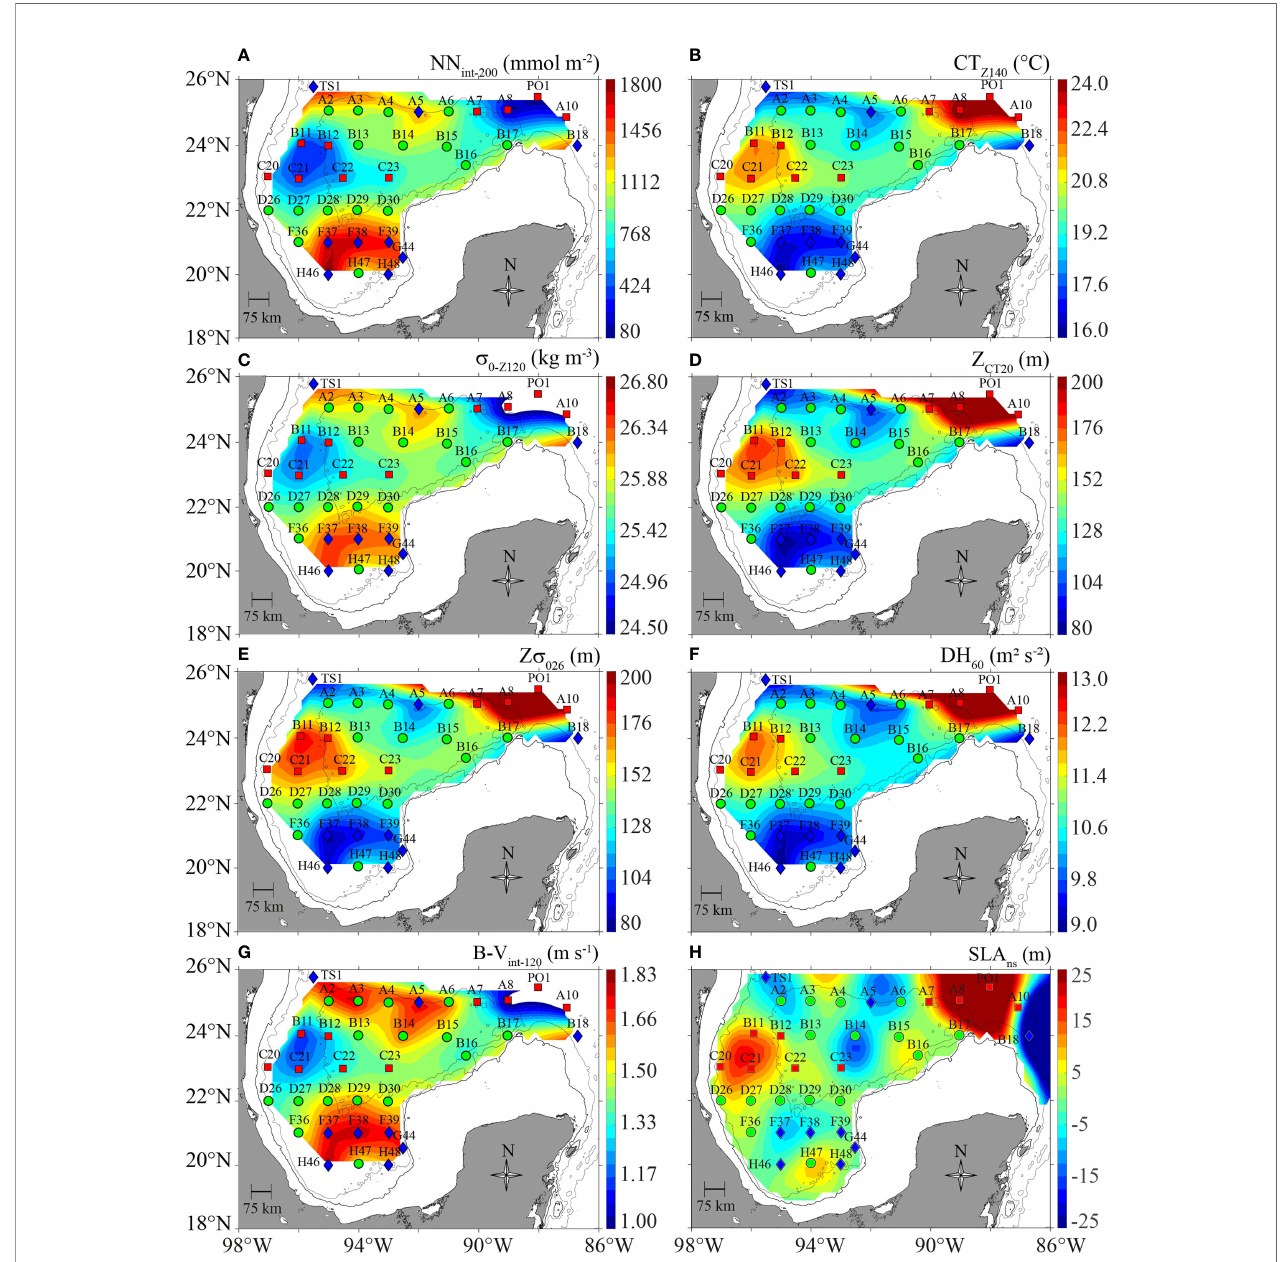
FIGURE 5 | Contour maps of (A) depth-integrated nitrate + nitrite (NN) between surface and 200 m (NN int-200 , mmol m -2 ), (B) Conservative Temperature at 140 m (CT Z140 , °C), (C) potential density anomaly at 120 m ( s 0-Z120 , kg m -3 ), (D) depth of the 20°C isotherm (Z CT20 , m), (E) depth of the 26 kg m -3 isopycnal (Z s 026 , m), (F) integrated dynamic height between 1000 – 60 m (DH 60 , m 2 s -2 ), (G) the integrated Brunt-Väisälä frequency between 15 – 120 m (B-V int-120 , m s -1 ), and (H) non- steric SLA during the cruise (cm). The blue rhombuses ( ), green circles ( ), and red squares ( ) correspond to cyclonic (CE), no eddy (NE), and anticyclonic (AE) stations,